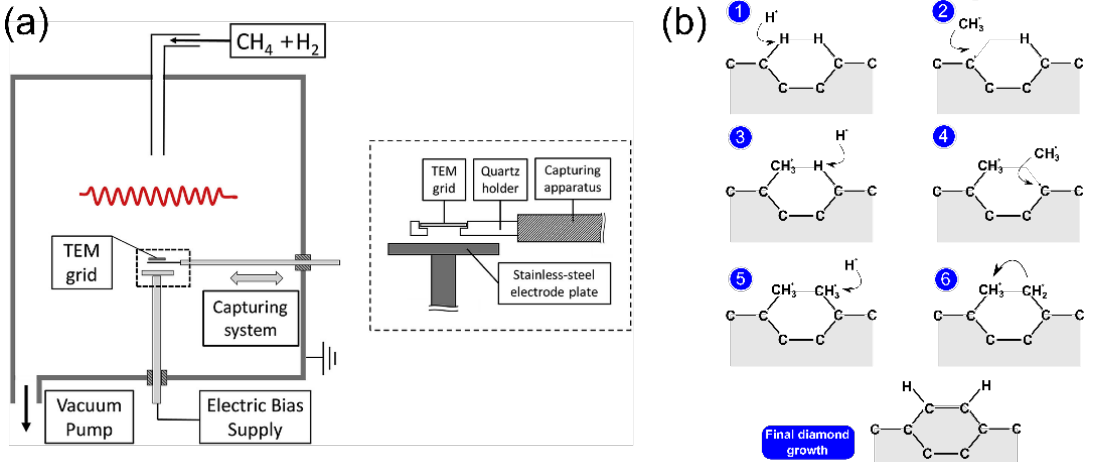
Figure 3. ( a ) Experimental setup for chemical vapor deposition (CVD) synthesis. The hot filament is required to dissociate the gas phase (CH 4 / H 2 mixture) into radicals, whereas the electrode plate is used to attract those radicals (mainly H • and CH • ) toward the substrate. Reproduced with permission from [34], Elsevier, 2016. ( b ) Schematization of the standard growth mechanism of nanocrystalline diamond film during CVD synthesis.